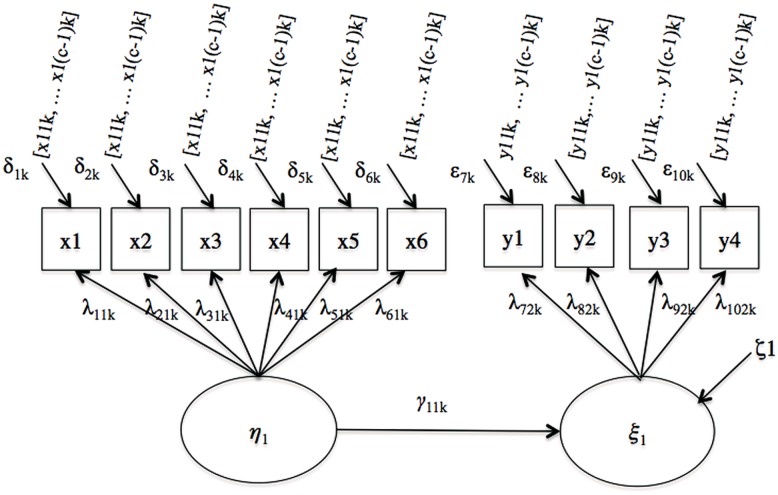
Simple regression.